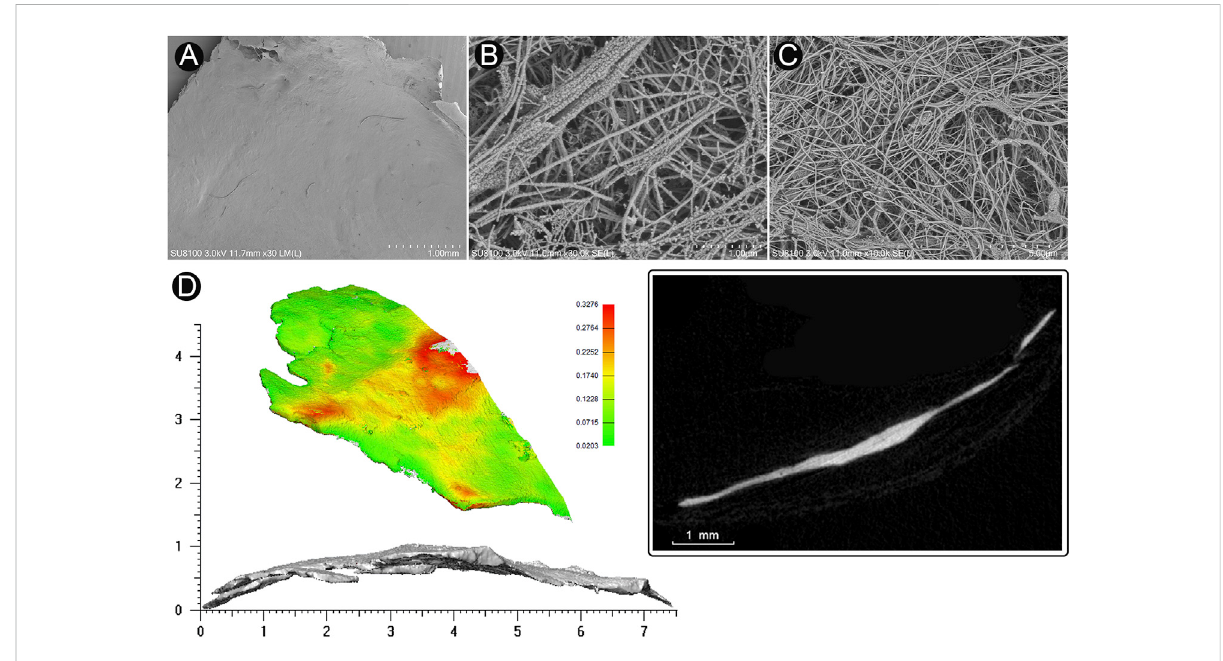
FIGURE 2 Microstructure and 3D reconstruction of dehiscent sigmoid plate. (A) SEM image of concave surface of the harvested sigmoid plate (magni fi cation × 30). (B) (magni fi cation × 30,000) and (C) (magni fi cation × 10,000) SEM image of collagenic fi bers of dura mater on the concave surface of the harvested sigmoid plate. (D) 3D reconstruction and μ CT image of the harvested sigmoid